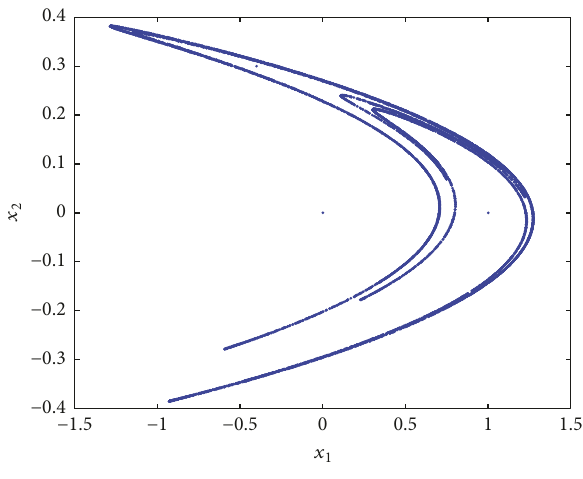
Figure 1: Attractor of H´enon